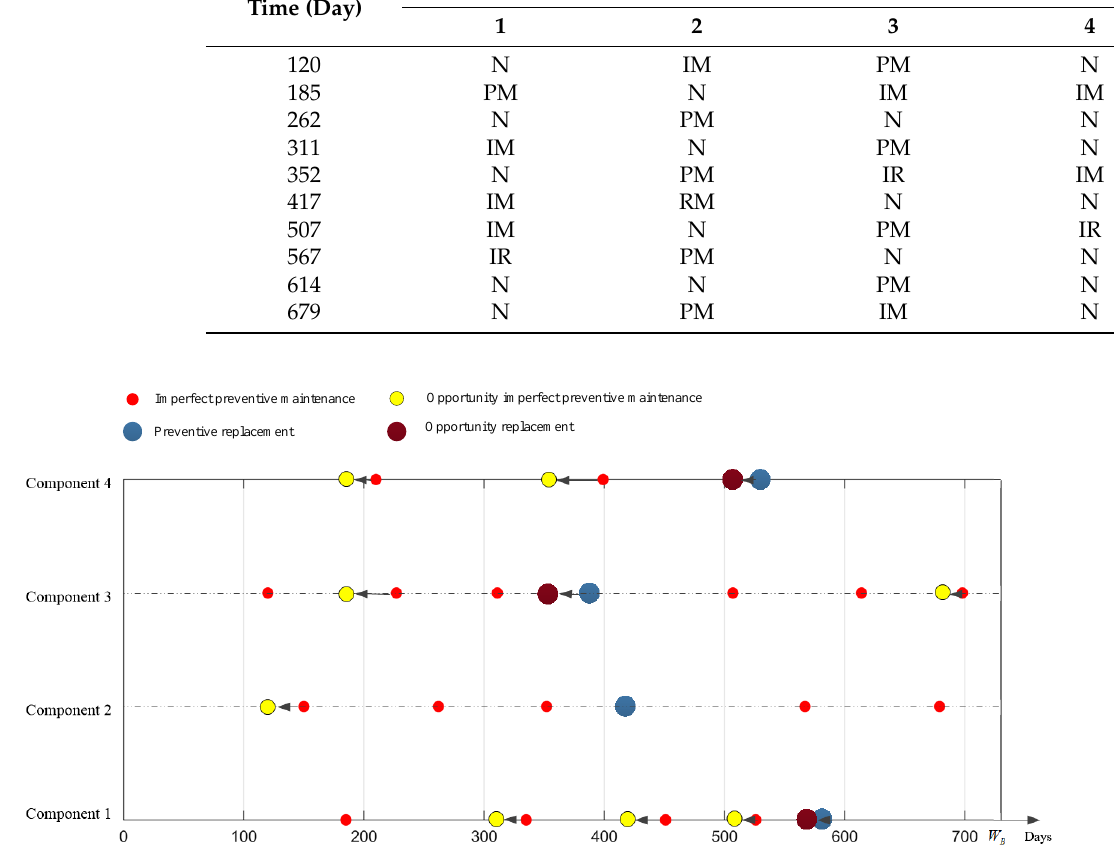
Figure 15. Opportunistic maintenance plan of the power transmission device.